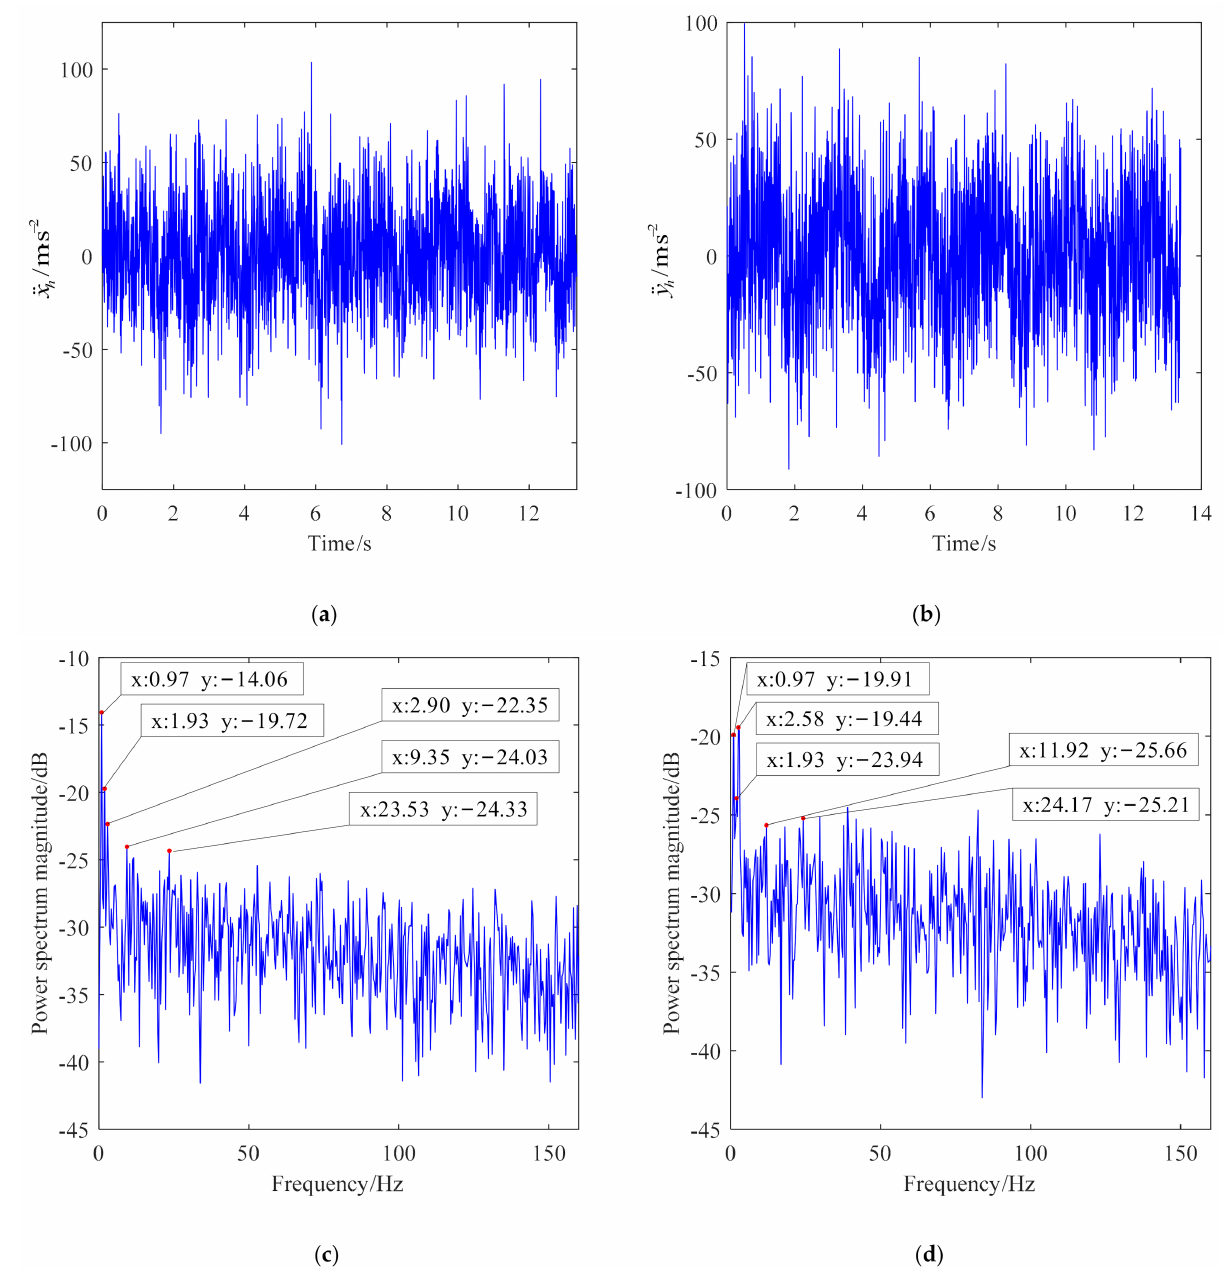
Figure 4. Acceleration characteristics of cutting head when f p = 10. ( a ) time-domain characteristics of acceleration in the x h -direction, ( b ) time-domain characteristics of acceleration in the y h -direction, ( c ) power spectrum of acceleration in the x h -direction, ( d ) power spectrum of acceleration in the y h